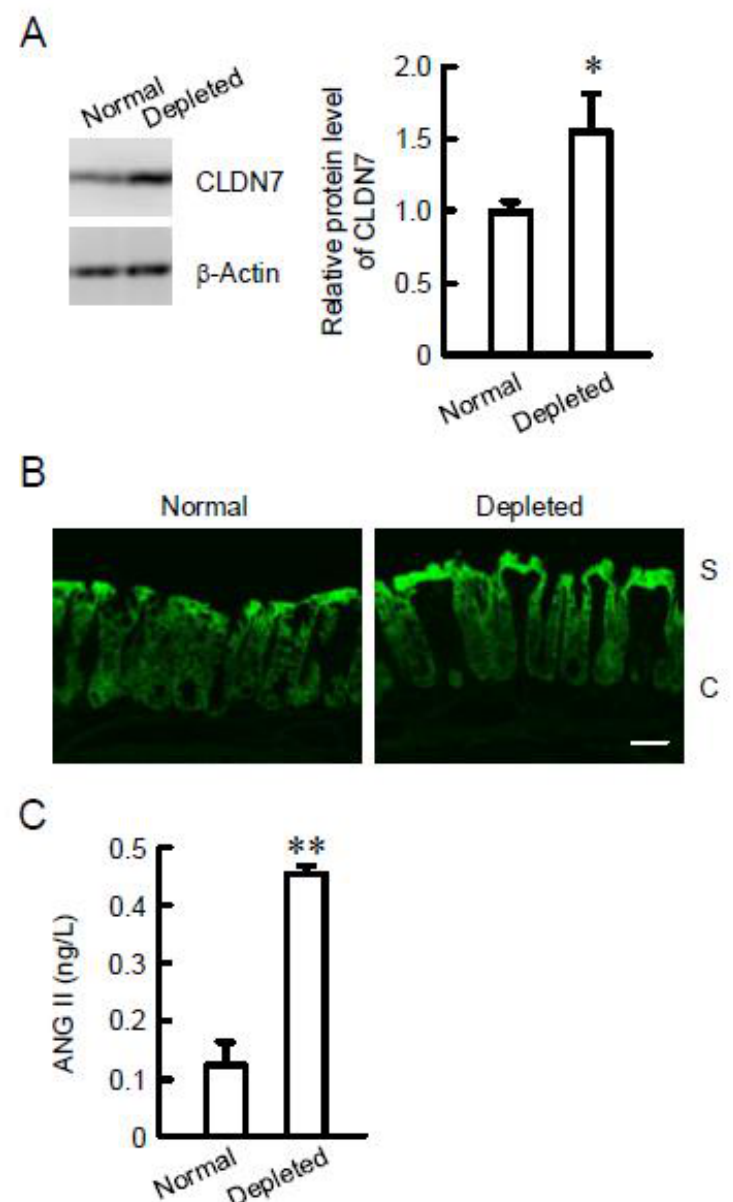
Figure 1. Effect of NaCl depletion on colonic claudin-7 (CLDN7) expression and serum angiotensin II (ANGII) concentration. ( A ) The distal colon was isolated from the mice fed with normal and NaCl-depleted diets. Cytoplasmic extracts including membrane and cytoplasmic proteins of colon were immunoblotted with anti-CLDN7 or β-actin antibody. The content of CLDN7 was represented relative to the values of normal. ( B ) The segments of distal colon were isolated from the mice fed with normal and NaCl-depleted diets. They were incubated with anti-CLDN7 antibody (green). S and C represent surface and crypt epithelia, respectively. The scale bar represents 50 µm. ( C ) Serum ANGII concentrations in the mice fed with normal and NaCl-depleted diets were measured. n = 3. ** p < 0.01 and * p < 0.05 significantly different from normal.